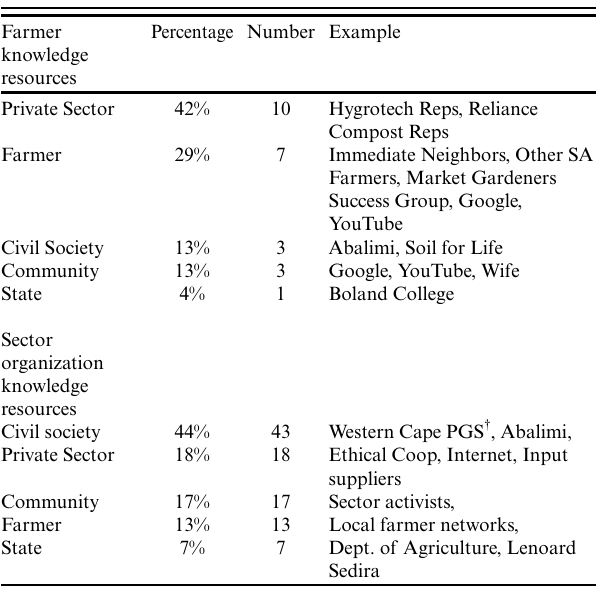
Table 3 . Information sources as listed by farmers and sector